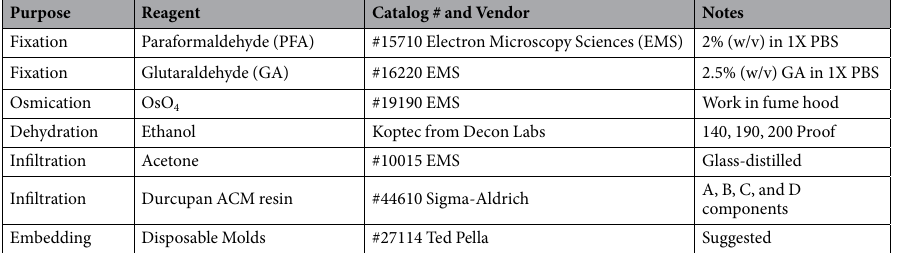
Table 2. Reagents for Small Whole-Brain Preparation for Micro-CT